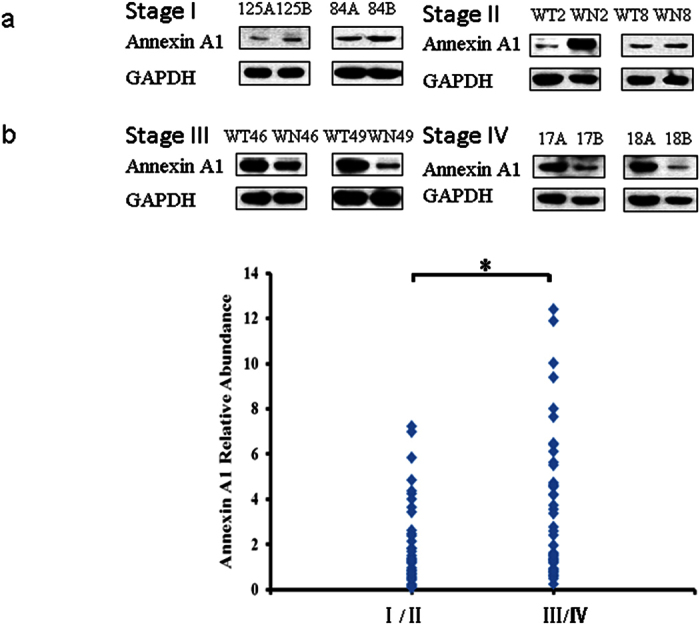
Validation of iTRAQ results by Western Blot.Annexin A1 expression was analyzed in 97 pairs of GC samples and matched adjacent normal gastric tissues by Western Blot. (a) Representative Western Blot image of Annexin A1 expression in stages I-IV GC samples and their matched adjacent normal gastric tissue (A or WT. cancer, B or WN. normal gastric tissue). The blots were cropped and full length blots are presented in Supplementary Figure S4. (b) Annexin A1 relative abundance in 97 GC samples. The bands were quantified by ImageJ and normalized to GAPDH, and the normalized density from GC samples was then divided by that of their corresponding adjacent normal gastric tissues. *P < 0.05.